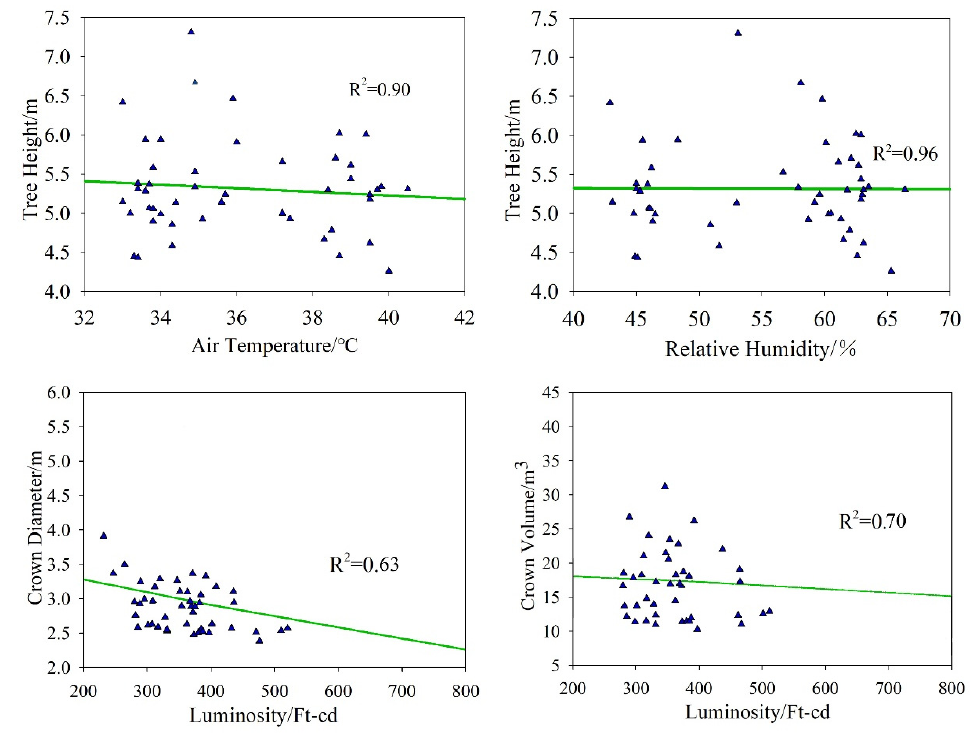
Figure 5. Linear relationship between morphological structure